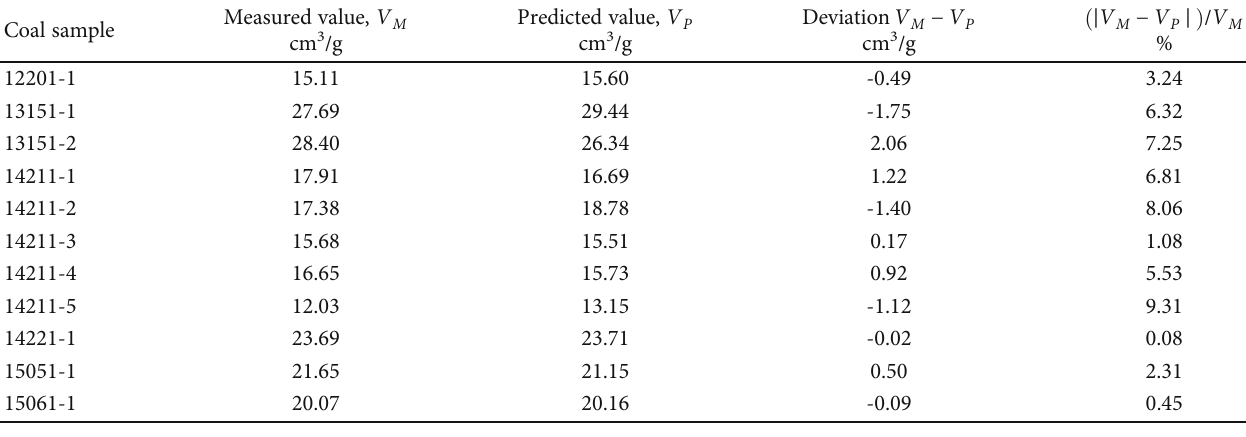
coal in the Xin ’ an coal mine. 1